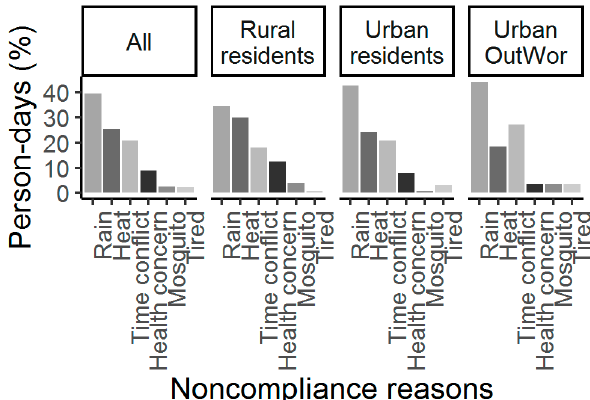
Figure 3. Self-reported noncompliance reasons of participants. There was no significant difference in the distribution of noncompliance reasons between Rural residents and Urban residents (Chi-Square = 3.04, Degrees of Freedom = 3, p -value = 0.39), or between Urban residents and Urban OutWor participants (Chi-Square = 2.93, Degrees of Freedom = 3, p -value = 0.39, p -value = 0.40).